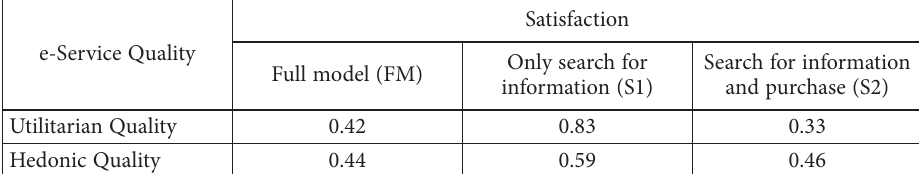
Table 9. Direct effects between e-service quality and satisfaction